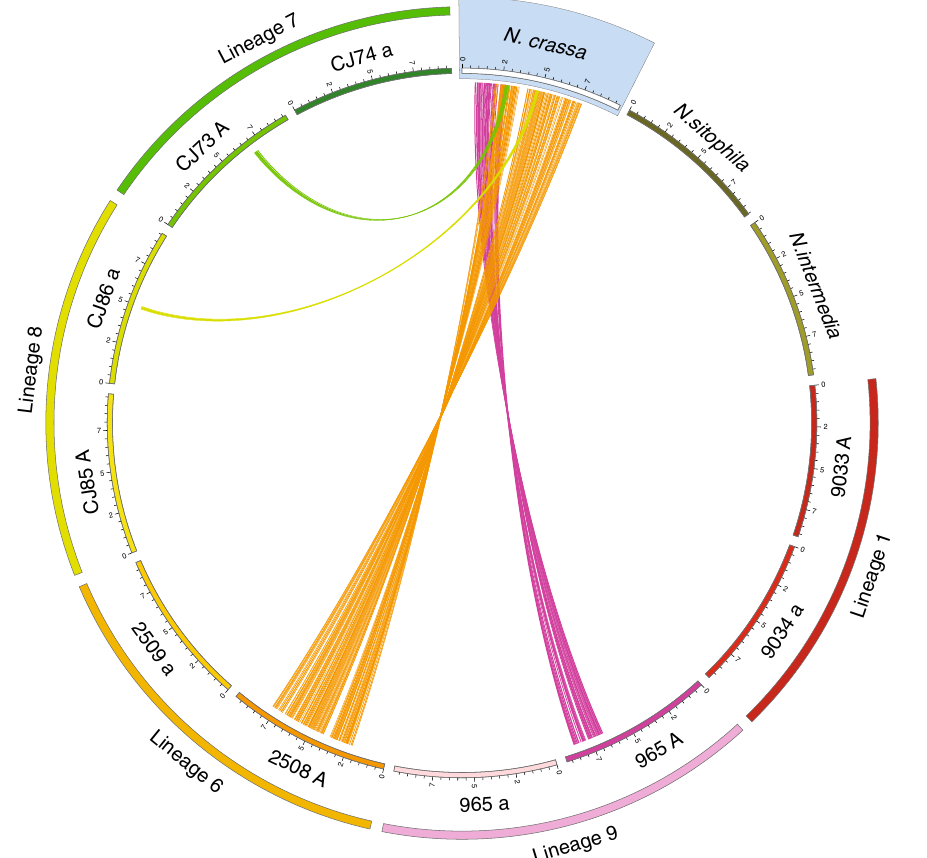
Fig. 1 Whole chromosome pairwise alignments of the mat chromosome of N. tetrasperma against N. crassa . The mat chromosome (chromosome 1) of the 10 high-quality de novo assemblies (eight N. tetrasperma , one N. sitophila and one N. intermedia ) generated for this study (Table 1), together with two mat chromosomes from Lineage 6 30 , were aligned to the N. crassa OR74A assembly 31 . Chromosomes are scaled in Mbp and only inverted regions larger than 100 kbp are shown. For N. tetrasperma , genomes of each of the two mating types from a single heterokaryon were sequenced separately. Each heterokaryon represent a phylogenetically distinct lineage (Lineages 1, 6, 7, 8 and 9) 27,33,34 . The previously identi fi ed set of inversions in 2508 mat A (Lineage 6) 30 is the biggest inverted region identi fi ed in N. tetrasperma . Strain 965 mat A (Lineage 9) carries a 1.9 Mbp inversion surrounding the mat locus, CJ86 mat a (Lineage 8) carries a 260 kbp inversion and CJ73 mat A (Lineage 7) a 320 kbp inversion. Both mating type strains of Lineage 1 completely lack large inversions on this chromosome, as do the N. sitophila and N. intermedia